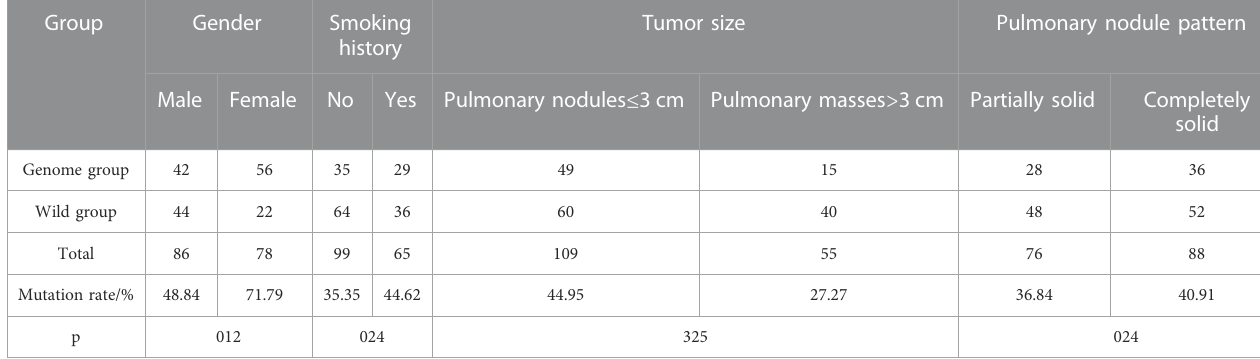
TABLE 2 Correlation of EGFR mutations in LUAD with chest CT imaging features.